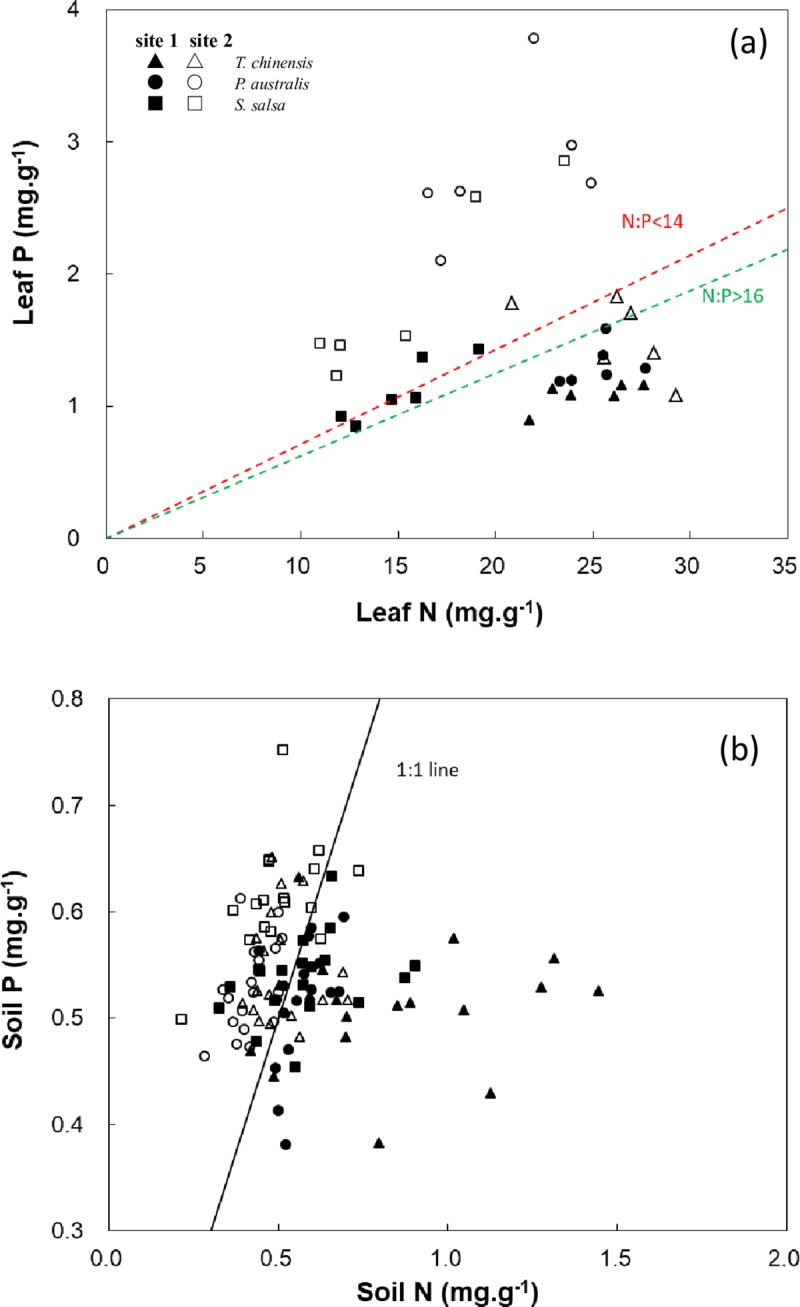
Relationships between N and P of plants and soils.(a) N versus P of plants; (b) N versus P of soils.